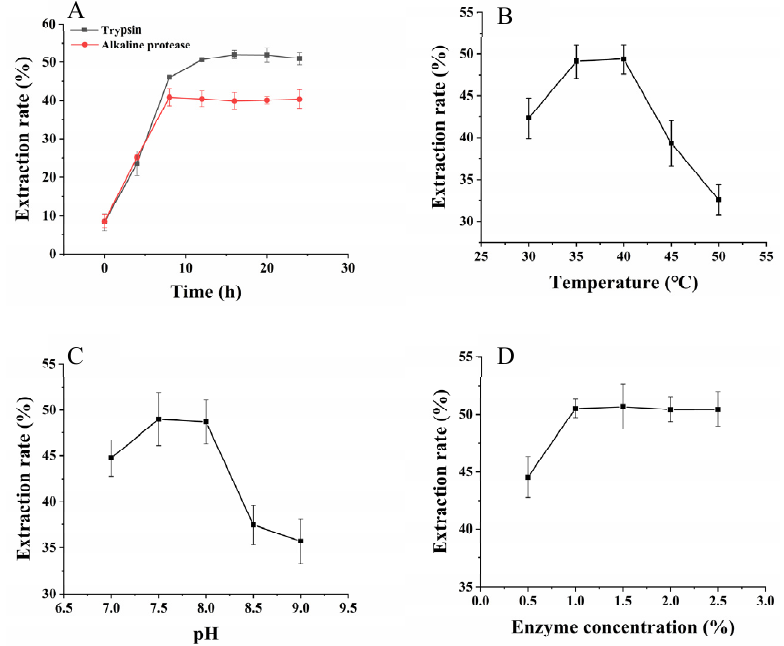
Figure 3. Comparison of two kinds of enzymes ( A ) and single-factor experiments of reaction temperature ( B ), reaction pH ( C ) and enzyme concentration ( D ). Table 4. Response surface test design and WBY polypeptide extraction